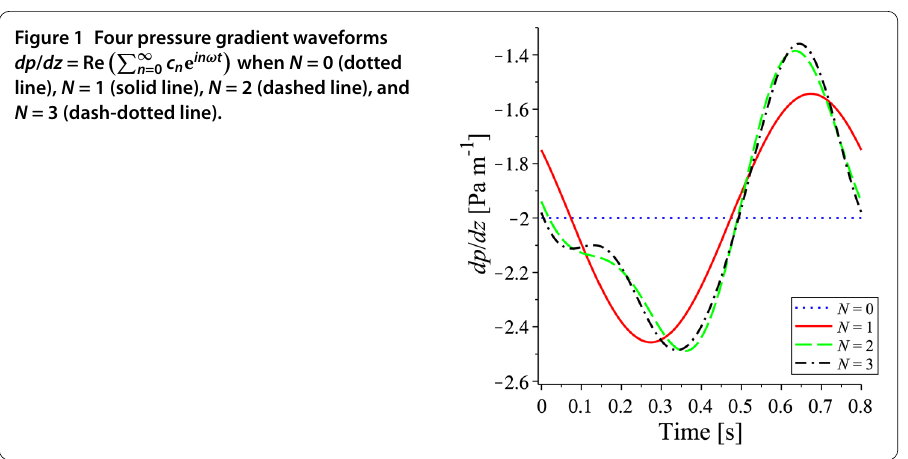
Figure 1 Four pressure gradient waveforms (cid:2)(cid:3) (cid:4) ∞ in ω t dp / dz = Re when N = 0 (dotted n =0 c n e line), N = 1 (solid line), N = 2 (dashed line), and N = 3 (dash-dotted